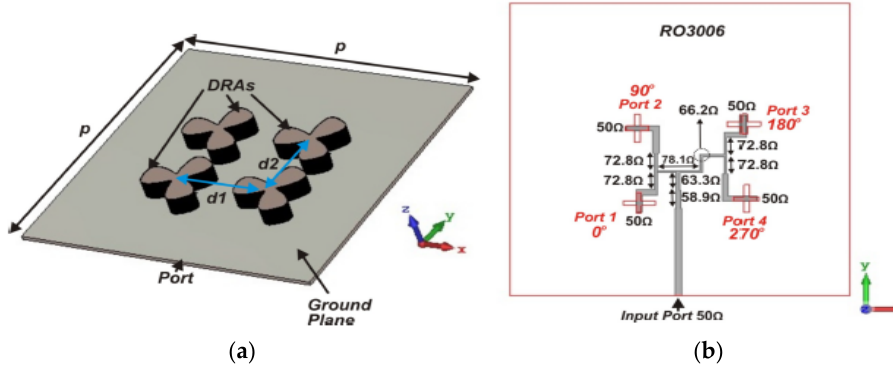
( b ) Figure 18. Geometry of CP substrate-integrated CDRA: ( a ) top view; ( b ) perspective view [77]. One of the popular methods to enhance impedance bandwidth, AR bandwidth, and gain of the proposed antenna is by integrating a SP feeding network into the antenna de- sign [78]. The DRA using a SP feeding network is proposed in for the mm-wave applica- tion at 30 GHz. As depicted in Figure 19, the proposed antenna consists of a 2 × 2 array of a flower-shaped DR placed on a ground plane. The cross-slots and SP feeding network are etched on the top and bottom sides of the Rogers RO3006 substrate, respectively. The array antenna is fed using a parallel feeding network, where each DR is fed sequentially,